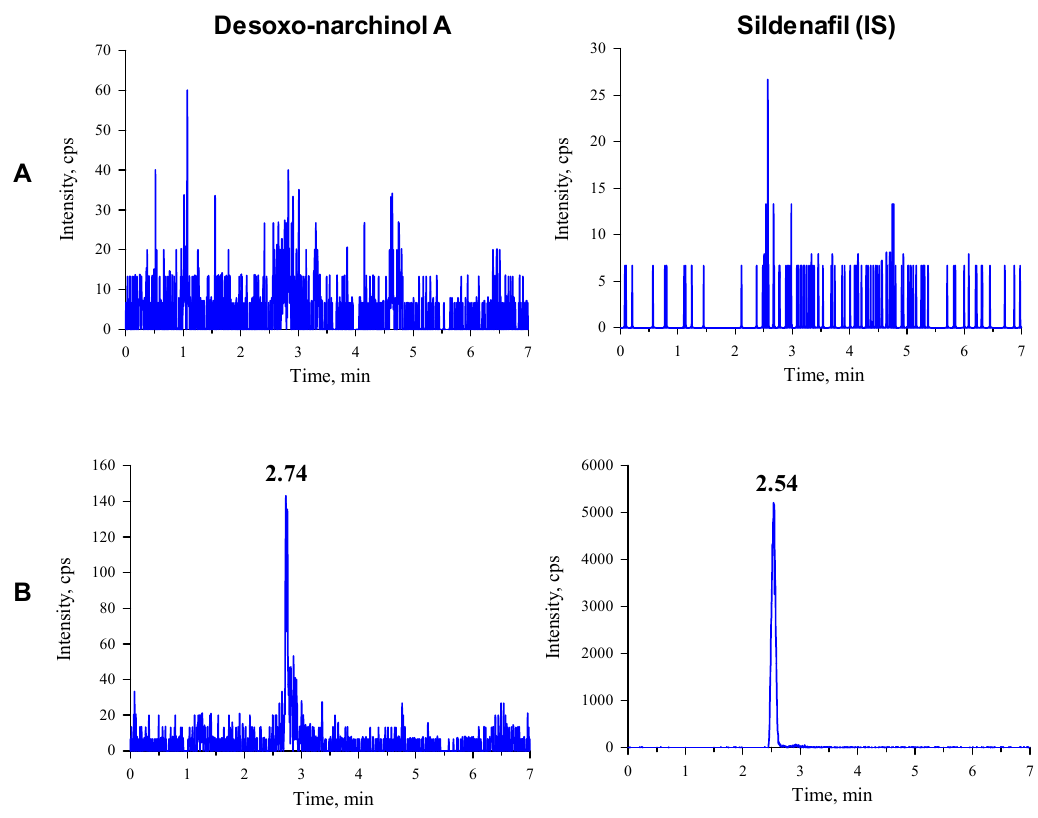
Figure 1. Representative chromatograms of desoxo-narchinol A (left) and the internal standard (right) in the ( A ) blank rat plasma and ( B ) blank rat plasma spiked with desoxo-narchinol A (LLOQ) and IS.